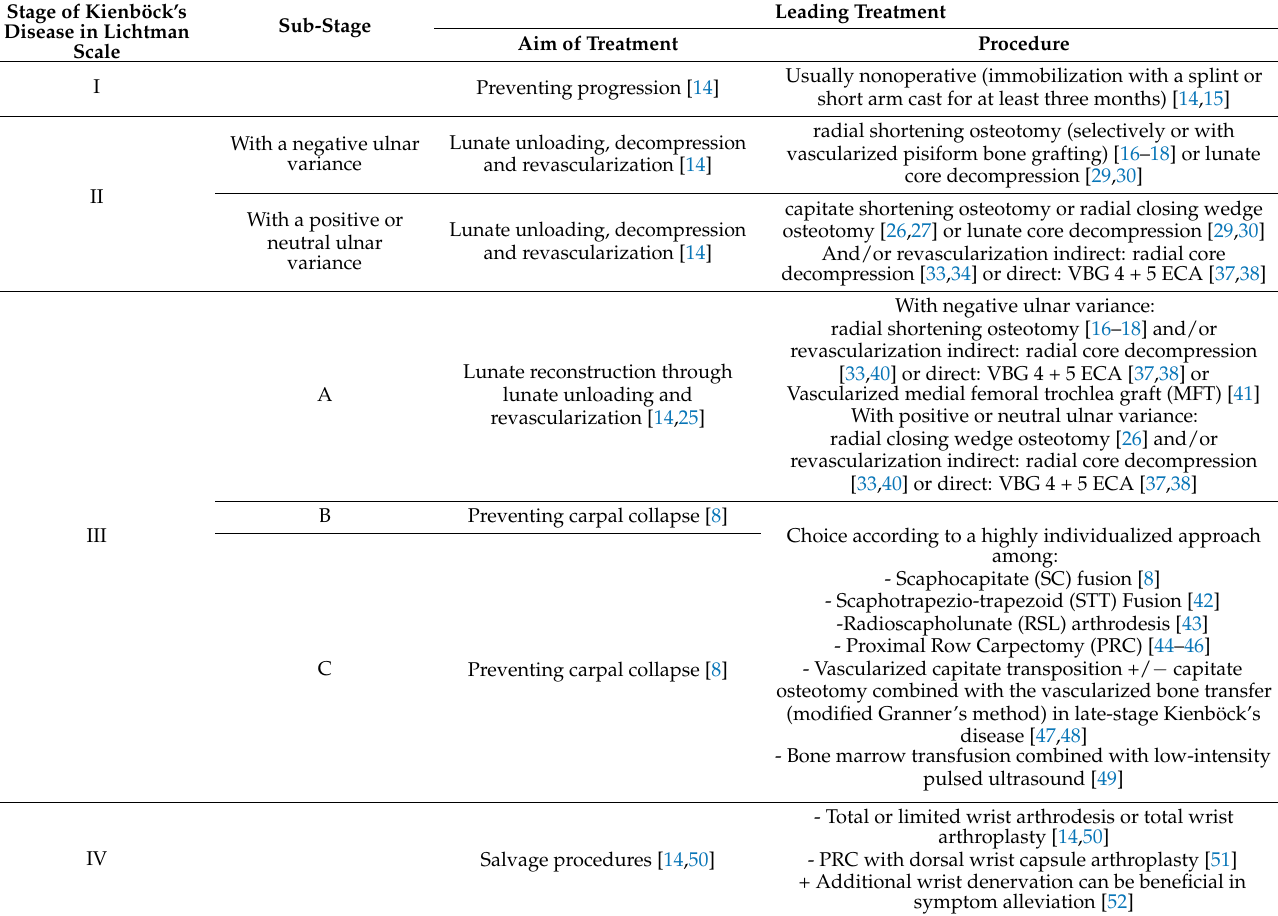
Table 2. Recommended treatment strategies for each stage of Kienböck